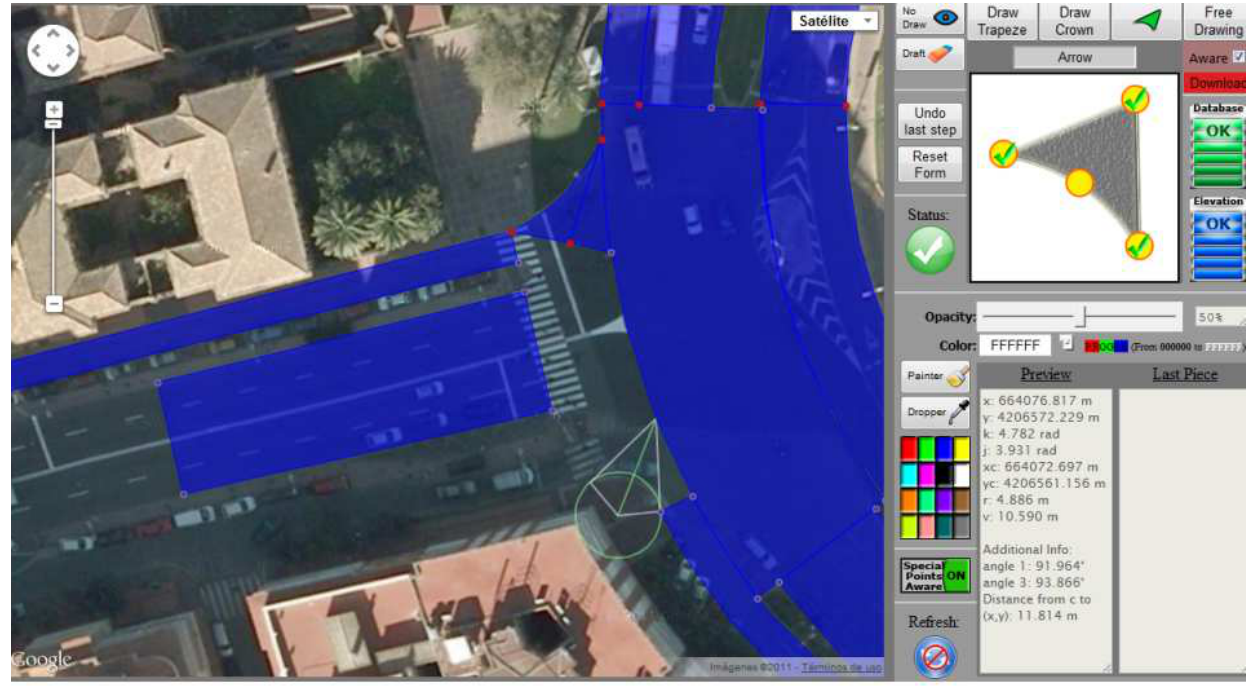
Figure 5. Overview of the web tool developed to create the road layer of the EEmap. On the right, the toolbar and drawing assistant; on the left, the map drawing overlaying the aerial image of an urban area of Murcia,